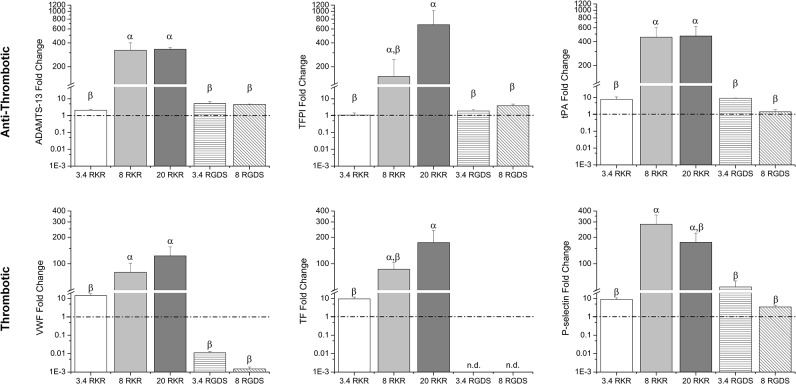
VEC hemostatic-related protein gene expression.VEC gene expression of anti-thrombotic related proteins [A disintegrin and metalloproteinase with a thrombopondin type I motif, member 13 (ADAMTS-13), tissue factor pathway inhibitor (TFPI), and tissue plasminogen activation (tPA)] and thrombotic related proteins [von Willebrand factor (VWF), tissue factor (TF), and P-selectin)] when cultured on combinations of different molecular weight formulations (3.4, 8, and 20 kDa) of hydrogels and adhesive ligands (RKR or RGDS) relative to VECs cultures on TCPS (indicated by dashed line). Groups not connected by same symbols are significantly different. p < 0.05.